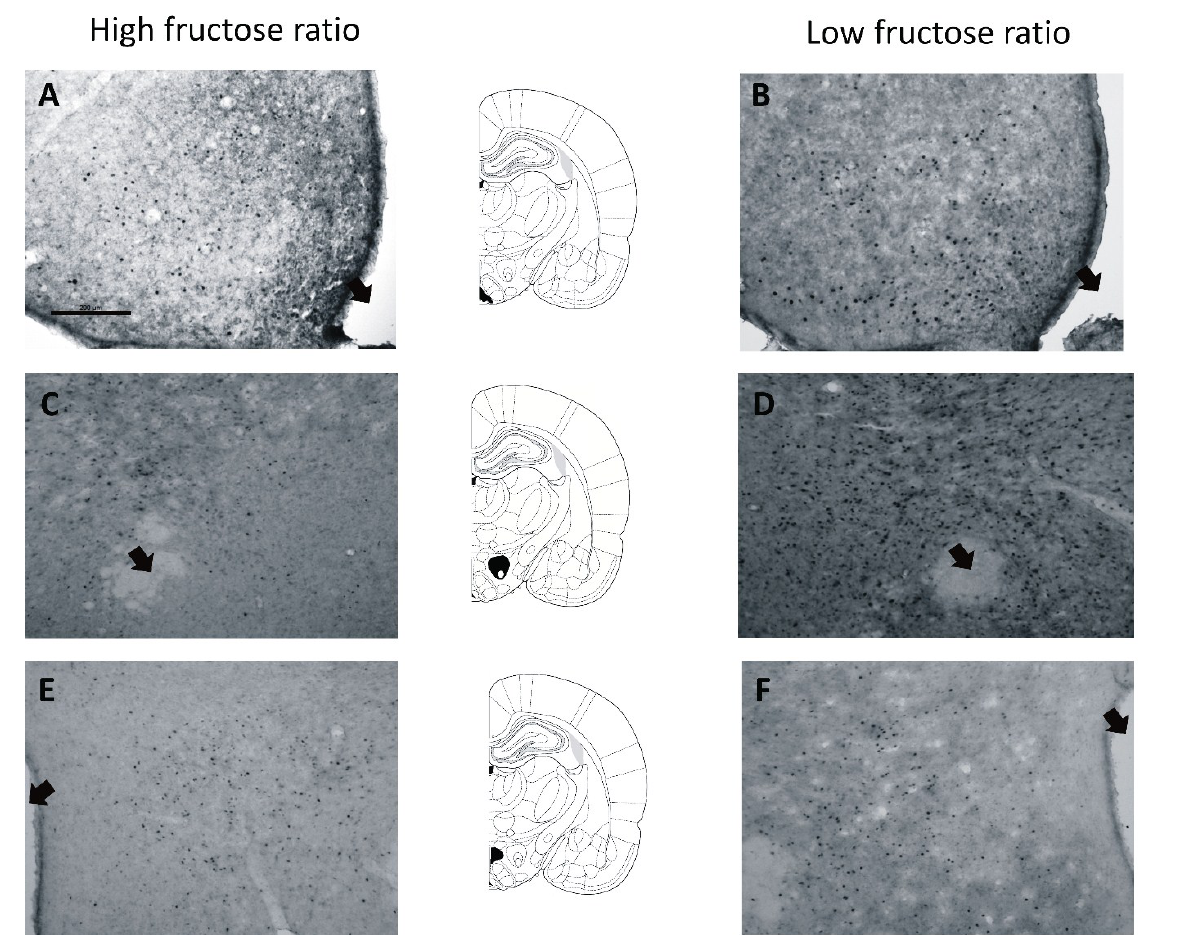
Figure 2. Representative microphotographs of c-Fos (calibration line = 200 μm) in the arcuate nucleus hypothalamus of rats that self-administered 55% F + 45% G ( A ) or 30% F + 70% G ( B ), perifornical area of the lateral hypothalamus of rats that self-administered 55% F + 45% G ( C ) or 30% F + 70% G ( D ), and dorsomedial hypothalamusof rats that self- administered 55% F + 45% G ( E ) or 30% F + 70% G ( F ). The black arrows indicate the location of the third ventricle (A,B,E,F) and fornix (C,D). Between each panel, diagrams from Paxinos and Watson (2004) with selected structures are